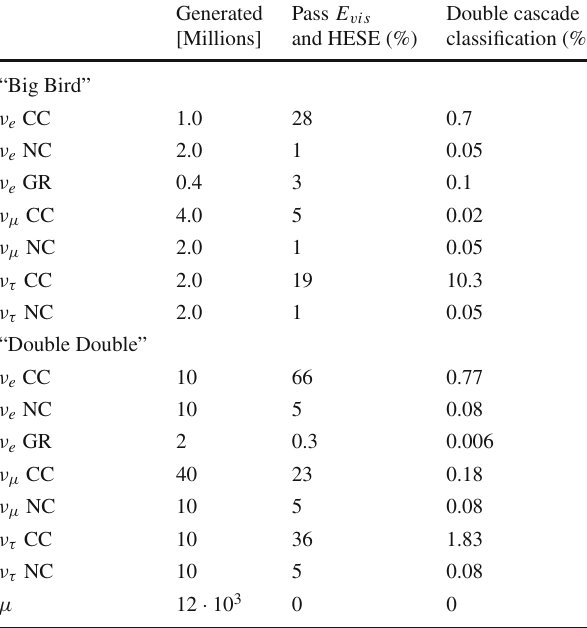
Table4 Targetedsimulationstatisticsfor“BigBird”and“DoubleDou- ble”. The number of total generated events (left), fraction of events passing the HESE selection and the visible energy ( E v is ) requirement (center), and fraction of events classified as double cascades (right) are shown for all classes of simulated interactions Generated Pass E v is Double cascade [Millions]